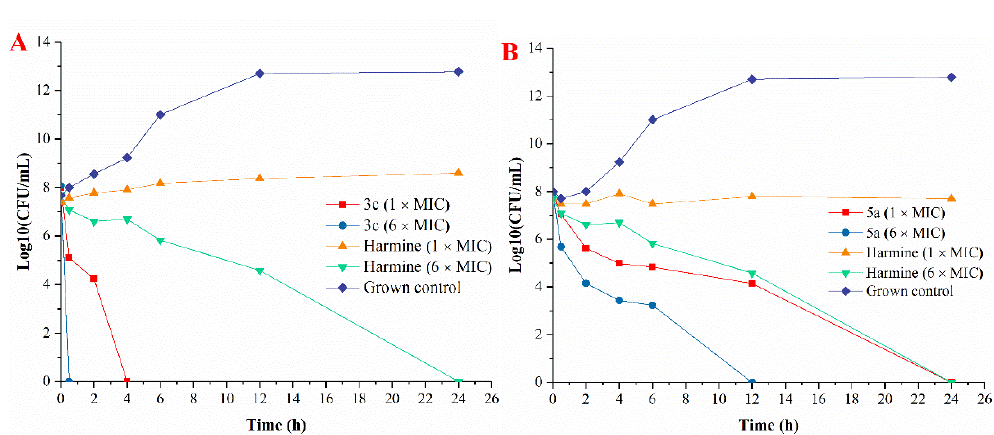
Figure 3. Time-kill kinetics of compound 3c ( A ) and 5a ( B ) at 1 × and 6 × MIC against S. aureus (CICC 10384).